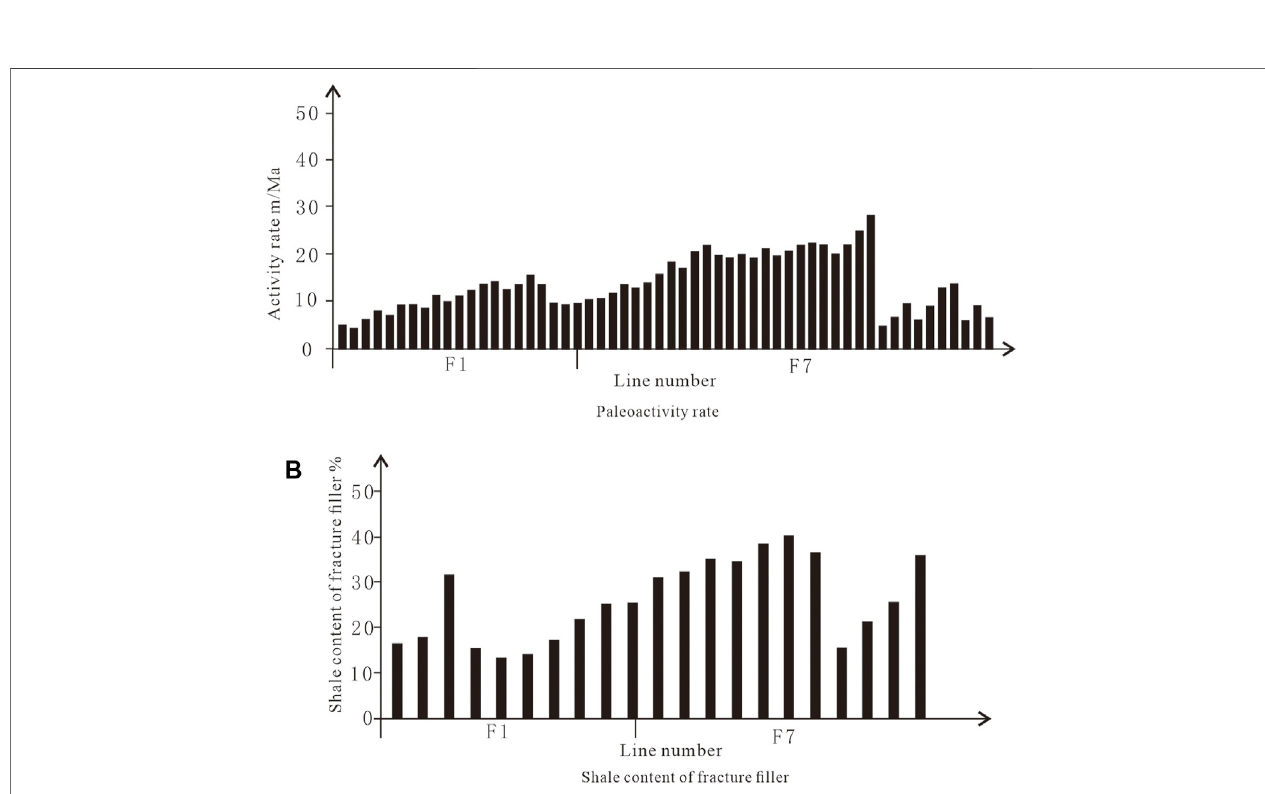
FIGURE 7 | In the southwest part of the Jiuzhou fault, the internal source fault is con fi gured to transport oil and gas in the middle and lower sub-member of Es3.